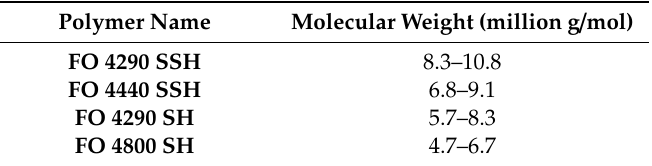
Figure 1. Structures of cationic gemini surfactants (Gem-A to Gem-D) used in this study. Table 1. Molecular weights of cationic polyacrylamide.